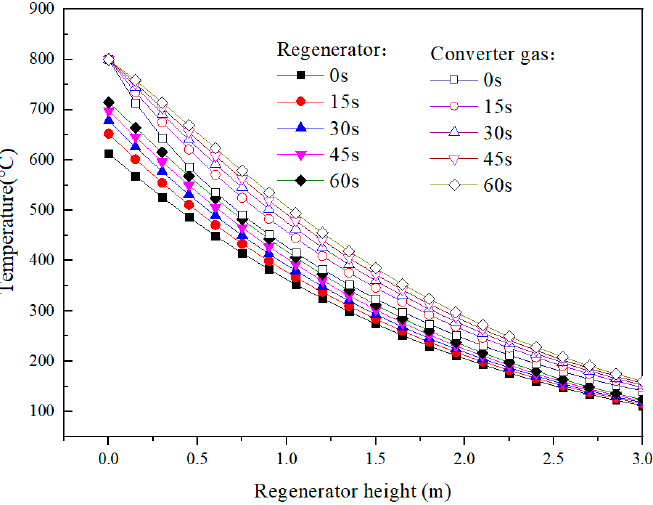
Figure 8. Temperature of converter gas and heat storage materials during heating period.